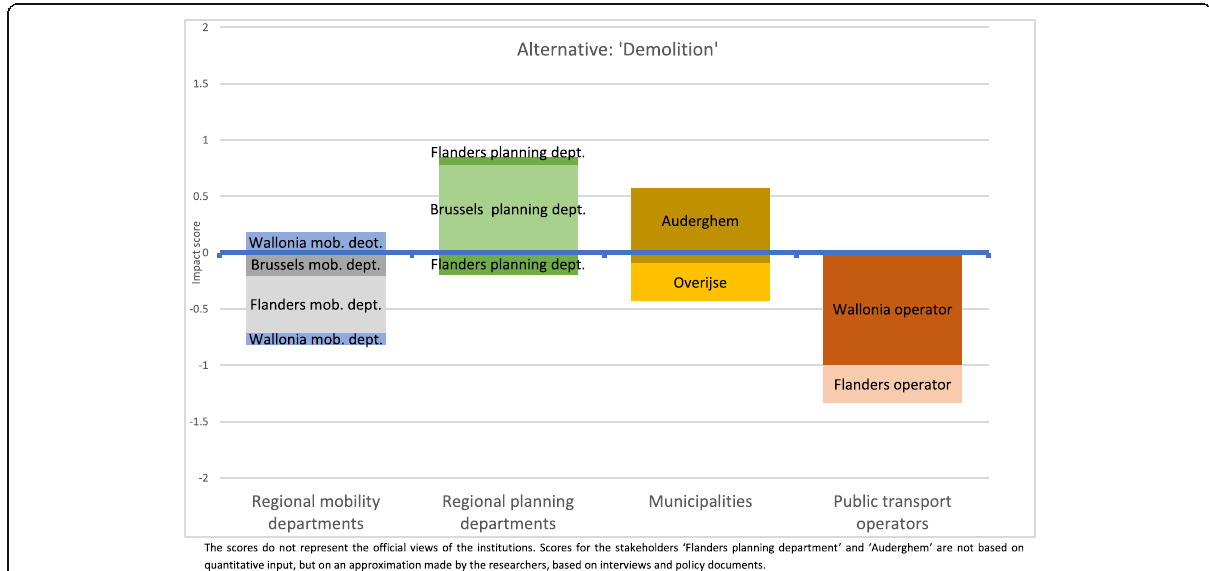
Fig. 8 Impact scores of the alternative ‘ Demolition ’ . (Maximum possible positive or negative impact for one stakeholder = 1, resp. -1). Figure by author